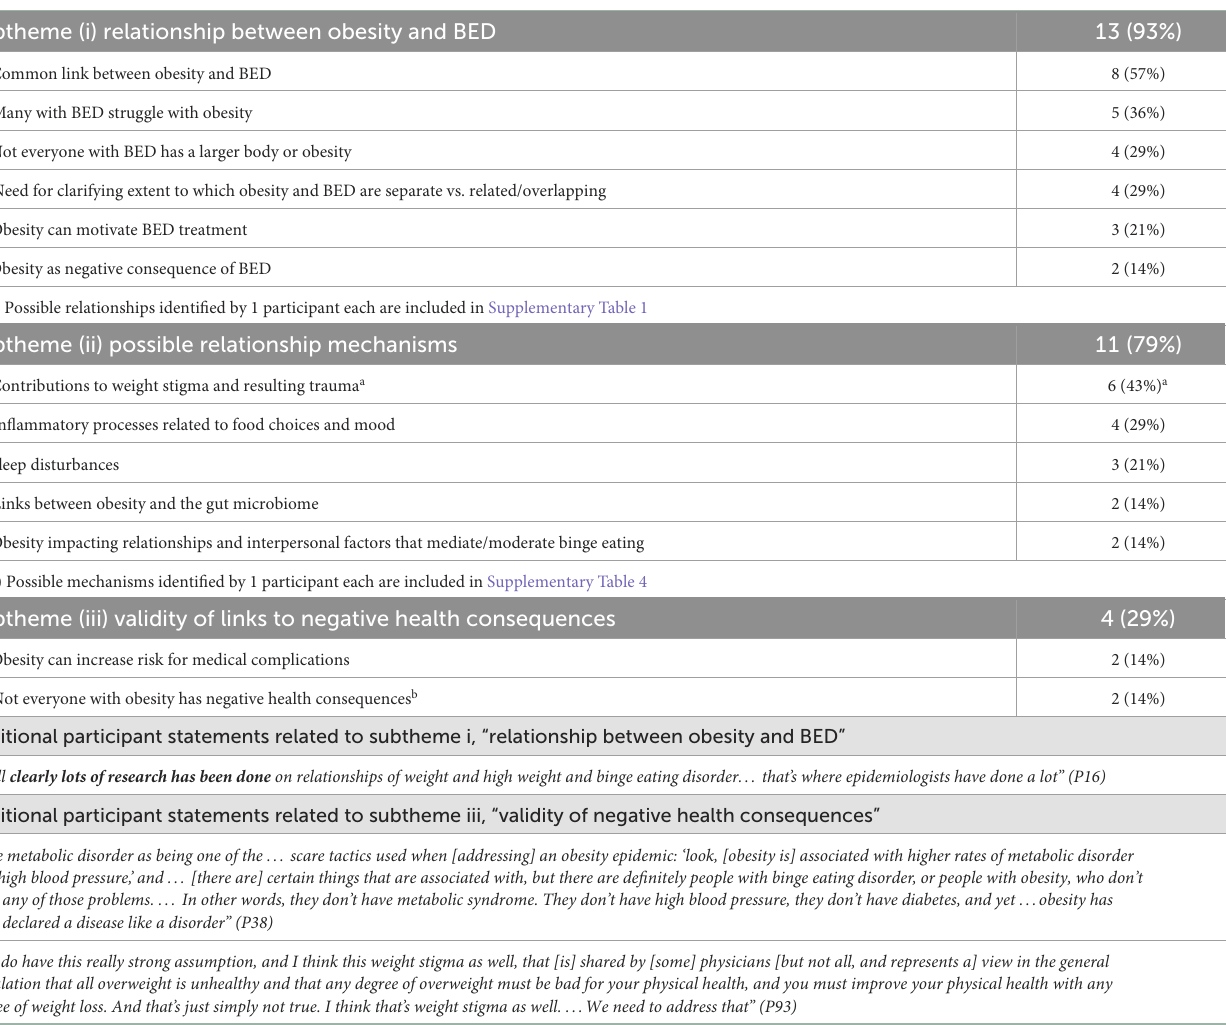
TABLE 4 Participant statements relating domain 1, “obesity domain” to binge eating disorder pathology